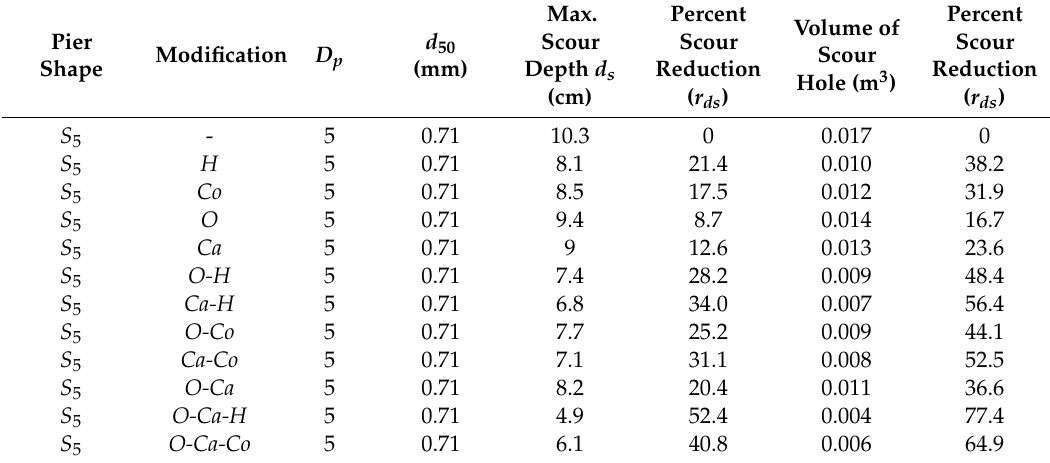
Table 5. Scour geometric parameters for D p = 5 cm and d 50 = 0.71 mm.